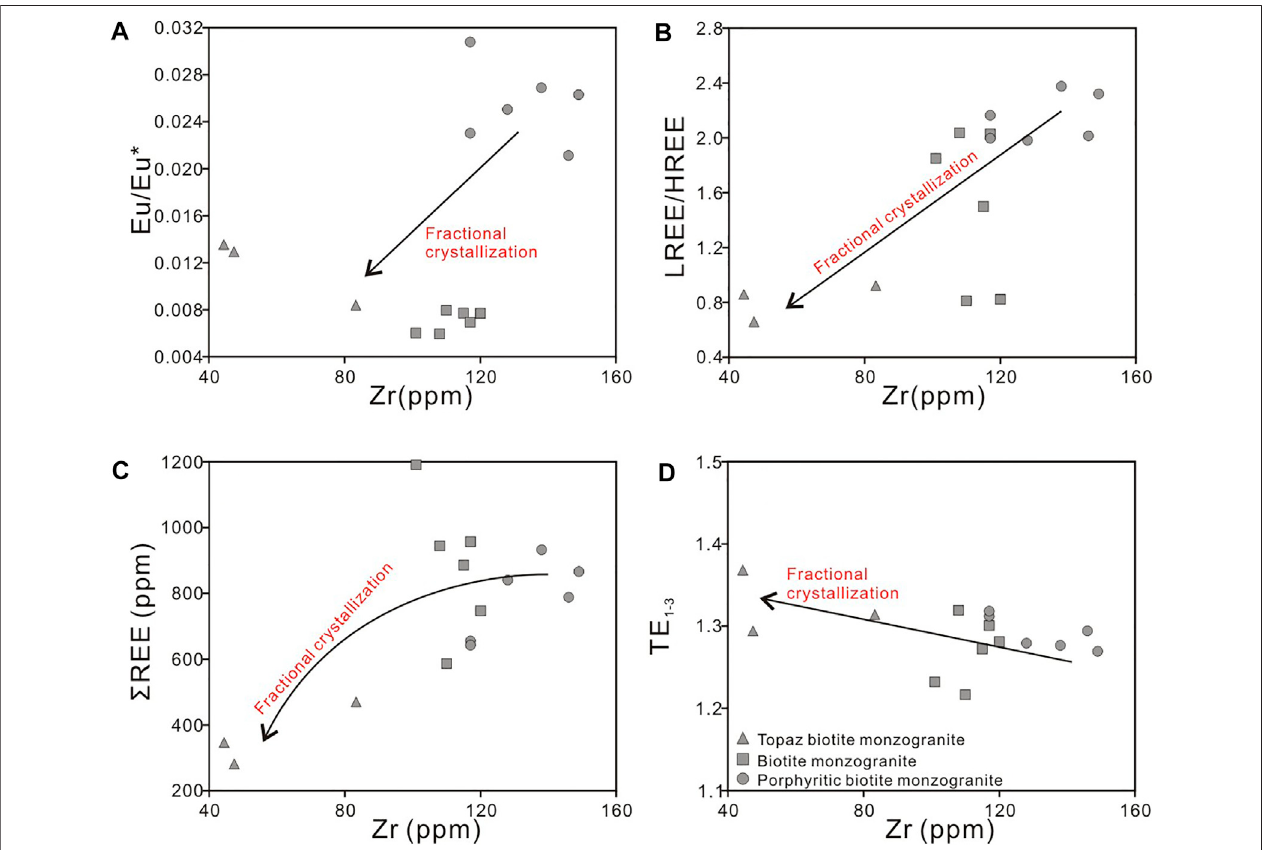
FIGURE 12 | Plots of Zr vs (A) Eu/Eu*, (B) LREE/HREE, (C) (cid:1) REE, and (D) TE 1,3 for the different biotite monzogranite lithofacies from the Jianfengling pluton.